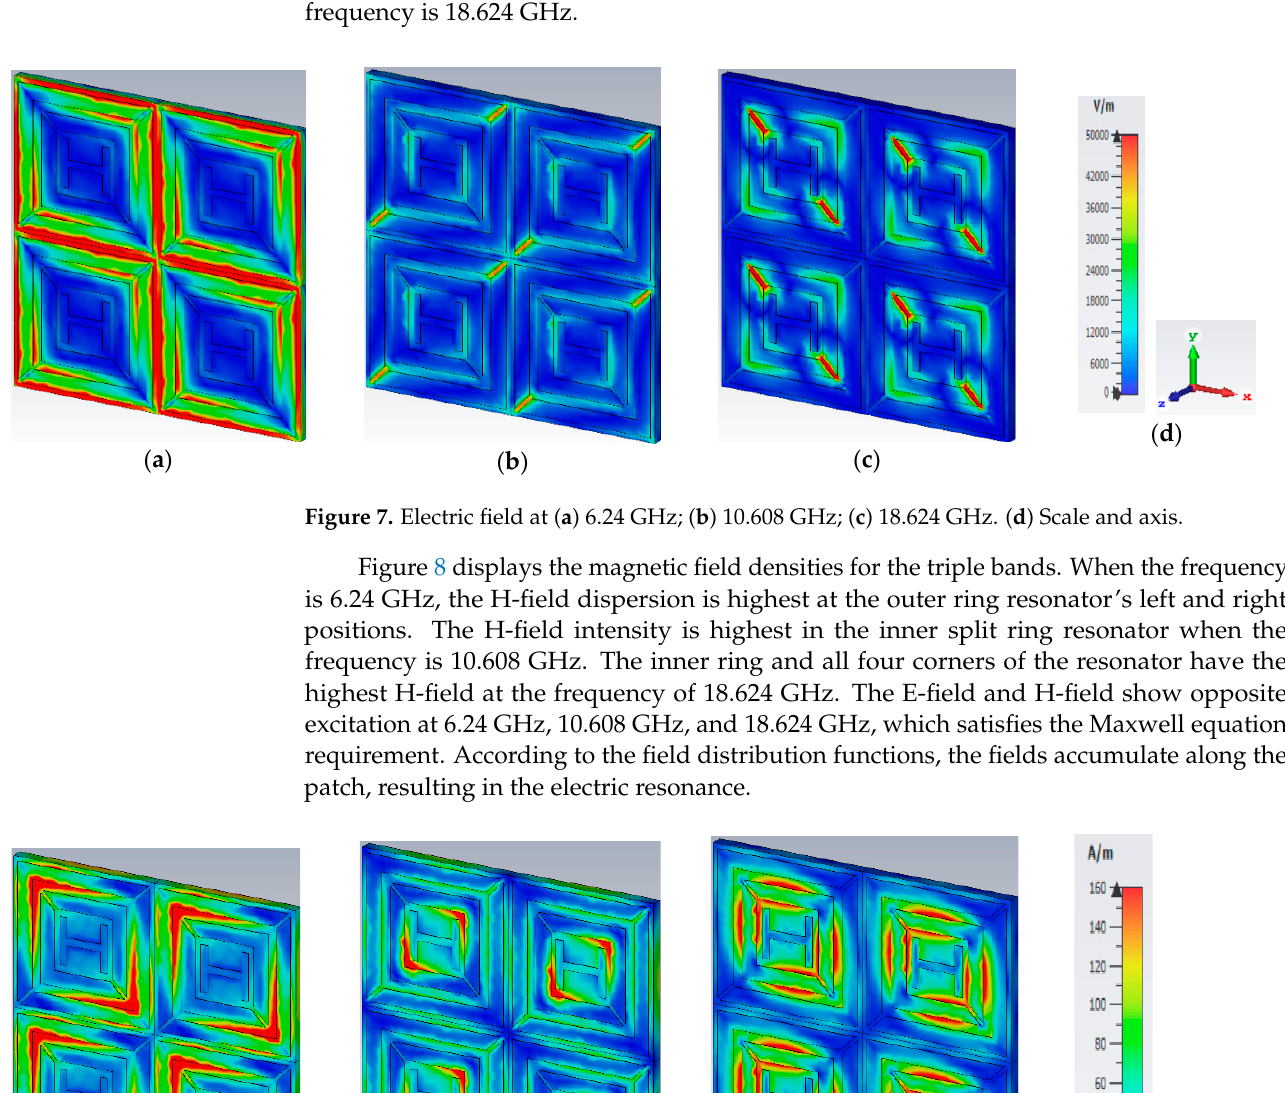
results using ADS and CST simulator. 11